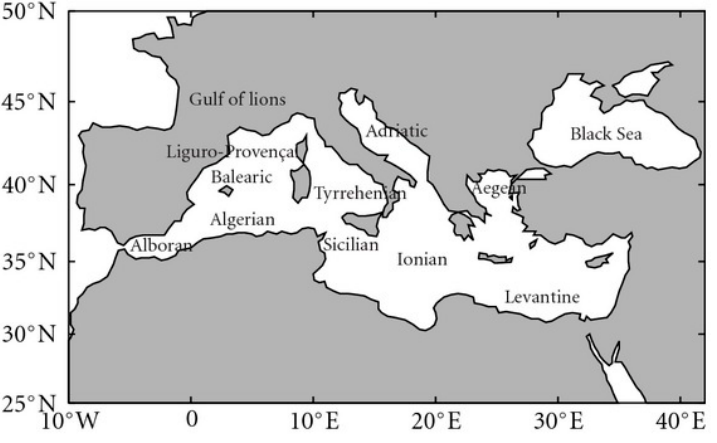
Figure 6. Map of the Mediterranean Sea. Source: Soto-Navarro, F. J., & Criado-Aldeanueva, F.; 2012 Figure 6 . Map of the Mediterranean Sea. Source : Soto-Navarro, F. J., & Criado-Aldea- nueva, F.; 2012 [19].